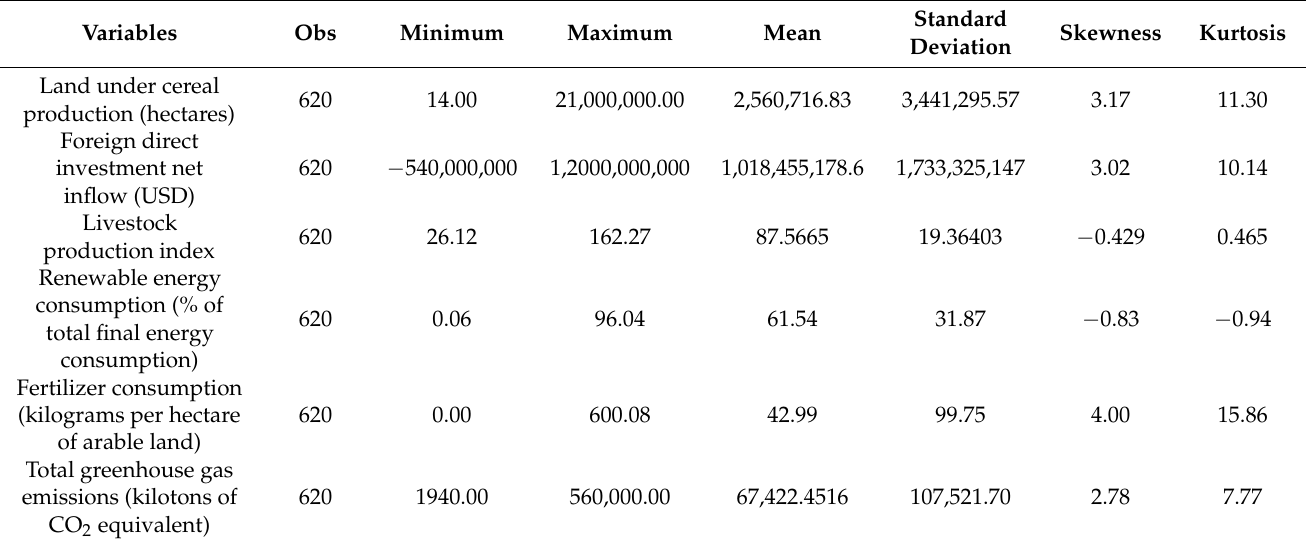
Table 3. Descriptive statistics of the